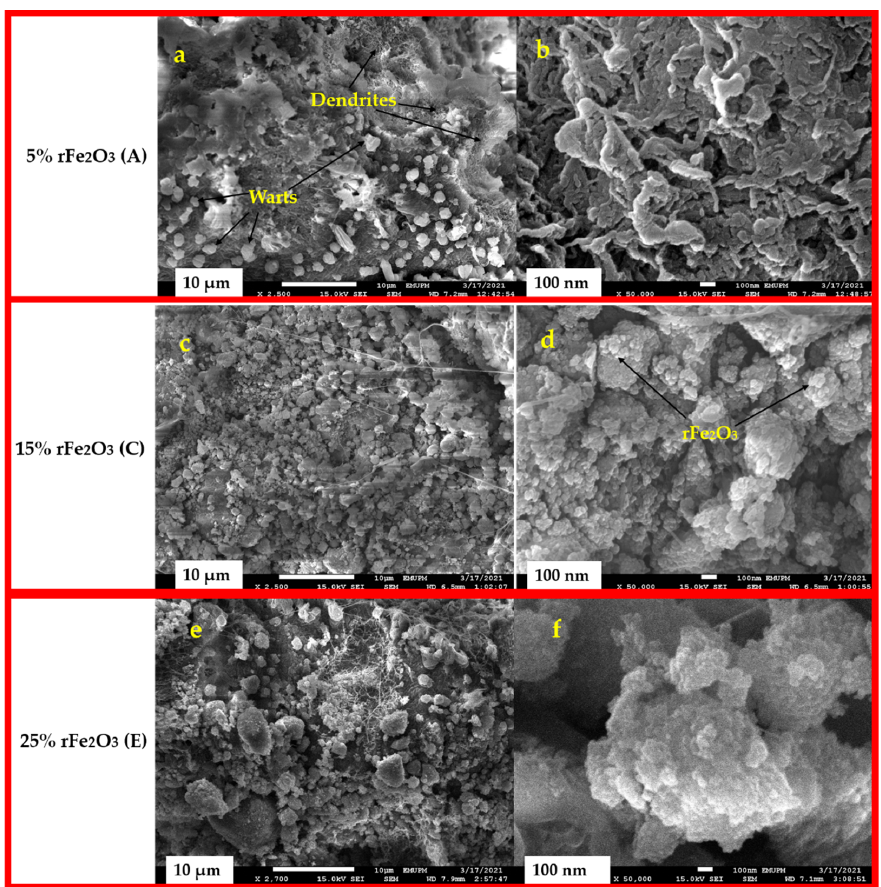
Figure 7. FESEM of rFe 2 O 3 –PTFE nanocomposites: 5% rFe 2 O 3 ( A ) nanocomposite ( a , b ), 15% rFe 2 O 3 ( C ) nanocomposite ( c , d ), and 25% rFe 2 O 3 ( E ) nanocomposite ( e , f ).